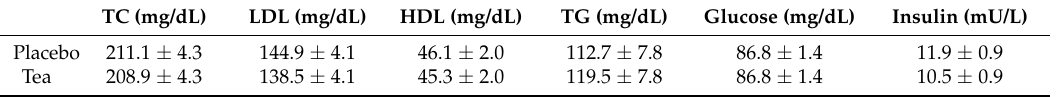
Table 4. Plasma concentrations of lipoproteins, glucose, insulin, and